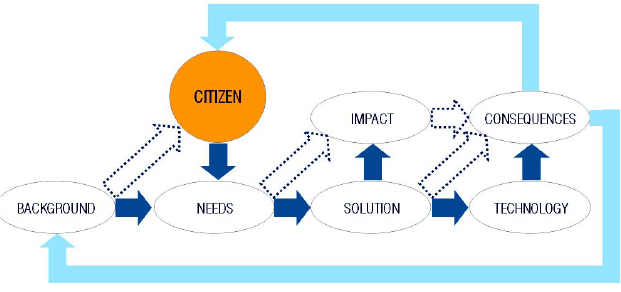
Figure 4. Scheme showing dependencies between the different elements of analysis.